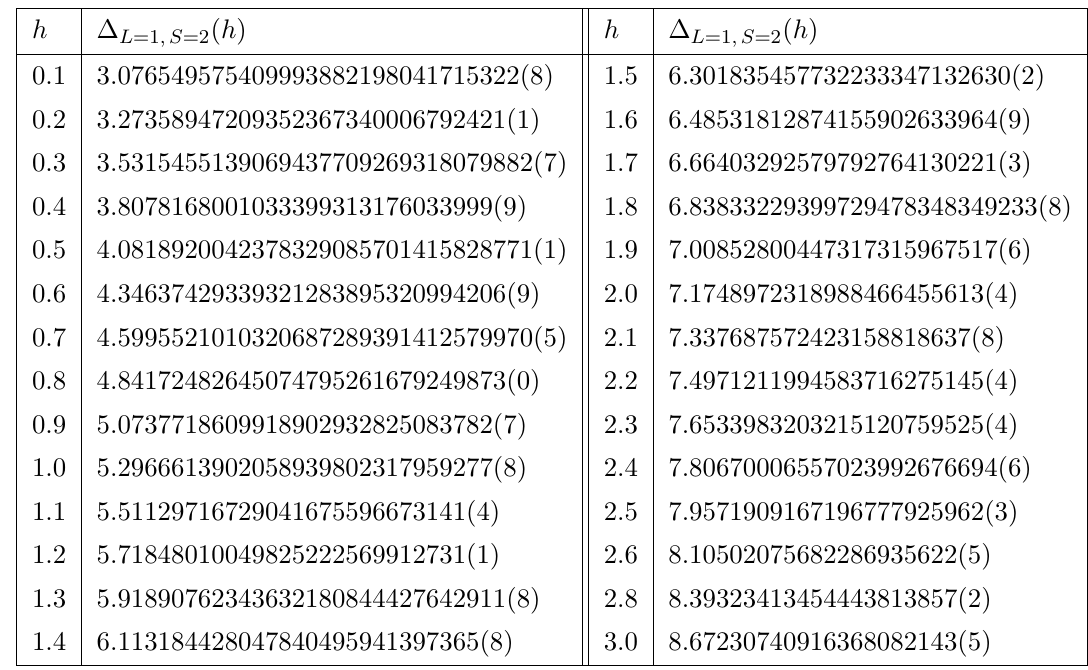
Table 7 . Numerical results for (cid:1) L =1 ;S =2 ( h ).